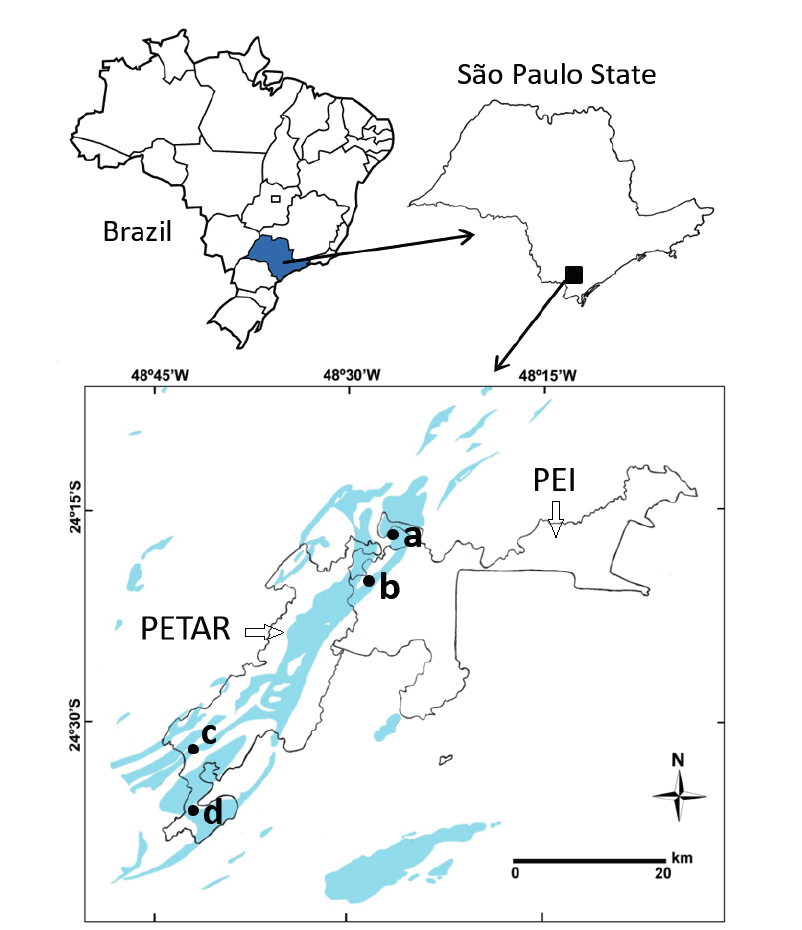
Figure 1. Map of the Alto Ribeira karst region (partial) in the state of São Paulo, Brazil, showing the border limits of the PETAR (Parque Estadual Turístico do Alto Ribeira) and Intervales State Park (PEI in Portuguese), and the corresponding type locality of the stygobitic aeglids: (a) Aegla leptochela and (b) A. charon n. sp. from Intervales, and (c) A. microphthalma and (d) A. cavernicola from PETAR. Light blue areas on map indicate distribution of limestone lenses. Modified from Fernandes et al .